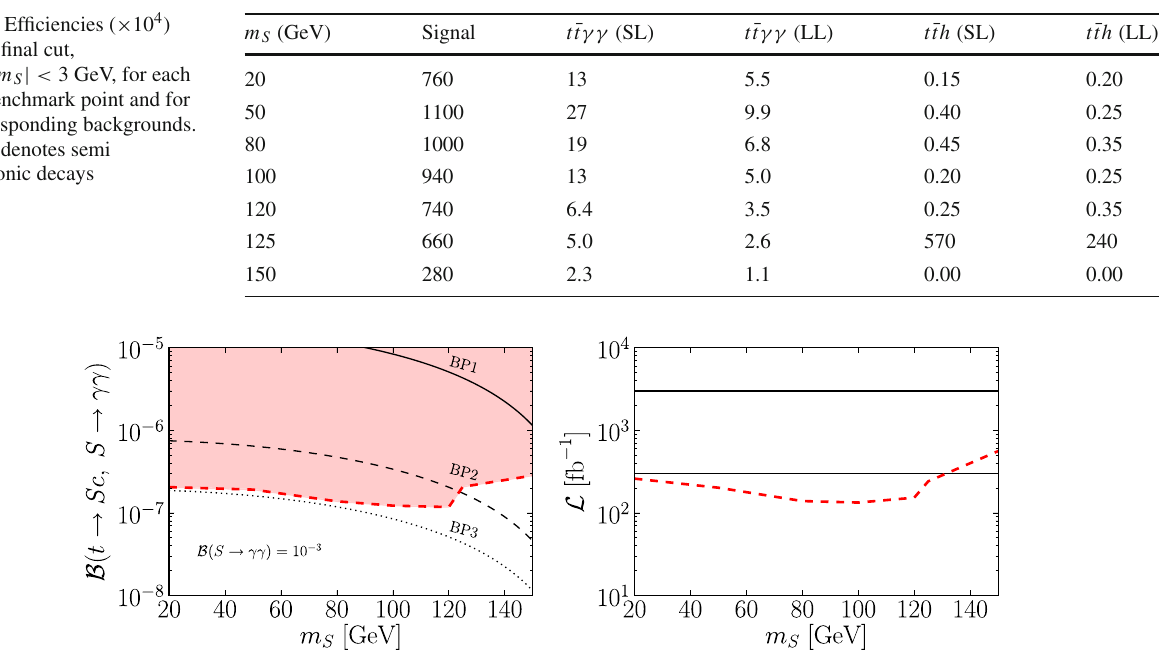
Table 7 Efficiencies ( × 10 4 ) after the final cut, | m γγ − m | < 3 GeV, for each S signal benchmark point and for the corresponding backgrounds.